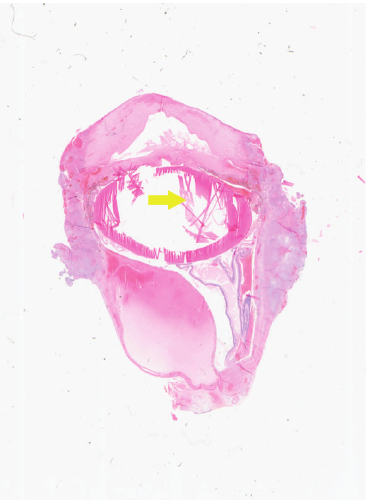
Figure 4: Low power view of the globe. The lens is artifactually fragmented (arrow). There is a marked inflammatory response centered at the limbus. In addition, there is retinal detachment and accumulationoffluidinthesubretinalspace.Thecorneaismarkedly thickened and there is early keratitis.